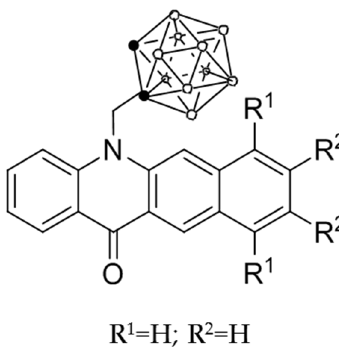
Figure 12. Geometry of the microdosimetric model; 25 neutrons were generated, some cells were hidden, and the central cell is sensitive.